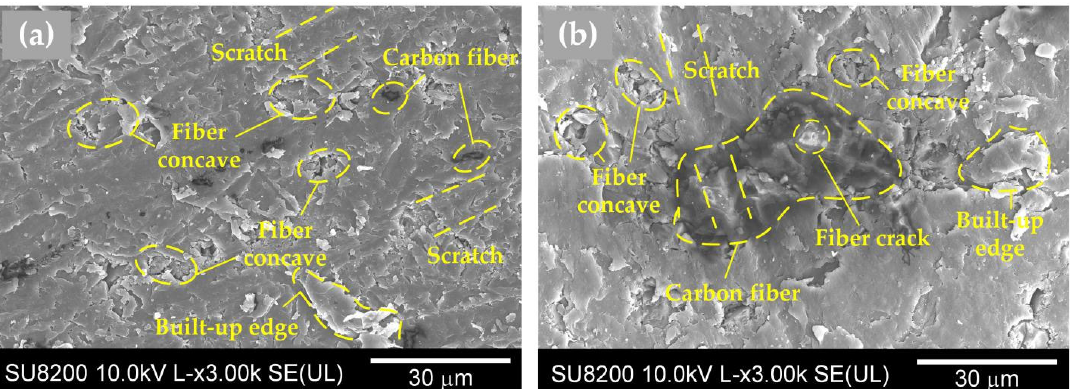
Figure 9. Surface morphology lapped with the #1000 mesh size silicon carbide abrasive paper of carbon-fiber-reinforced PEEK materials with different carbon fiber mass fractions, ( a ) carbon-fiber- reinforced PEEK with 10% carbon fiber mass fraction; ( b ) carbon-fiber-reinforced PEEK with 30% carbon fiber mass fraction.